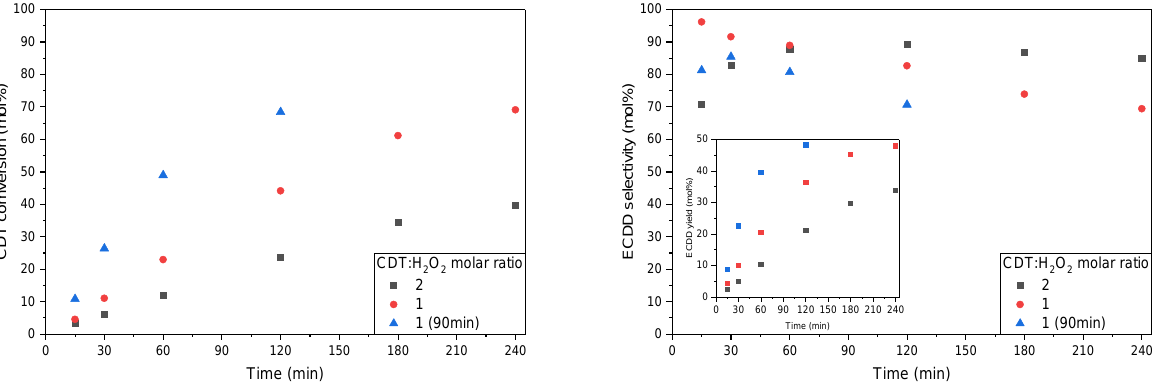
Figure 11. Graphs showing conversion of CDT ( left ), selectivity of transformation of CDT to ECDD ( right , main), and ECDD yield in relation to CDT ( right , insert) at different CDT:H 2 O 2 molar ratios and H 2 O 2 flow ratio in the processes conducted using a semi-bath method. Process conditions: temperature, 60 °C; solvent, i-PrOH, 90 wt%; catalyst, W-SBA-15, 5wt%; CDT:H 2 O 2 (9.54 wt% i-PrOH solution) molar ratio, 2. H 2 O 2 solution flow ratio: 2, 94 µL/h; 1, 105 µL/h; 1 (90 min), 246 µL/h.